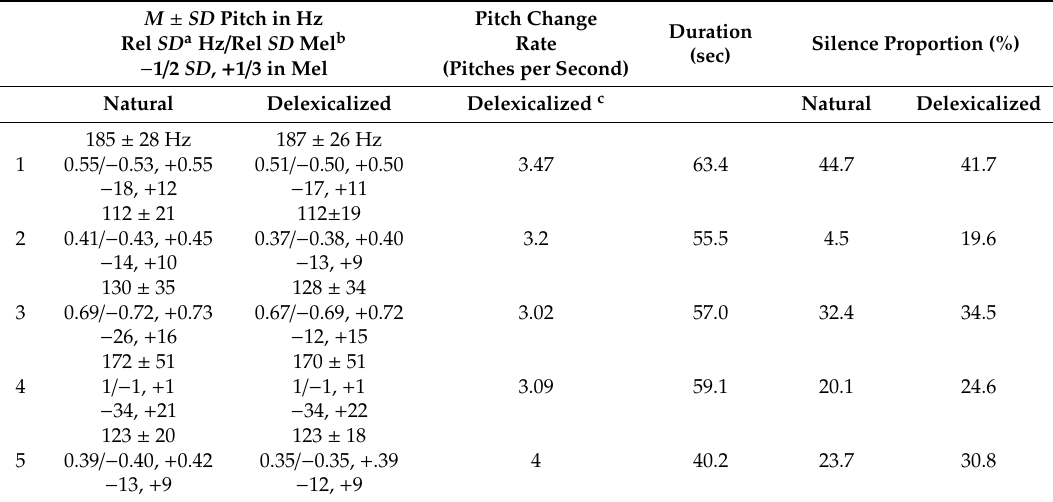
Table 1. Acoustic properties of the five stimuli used in the